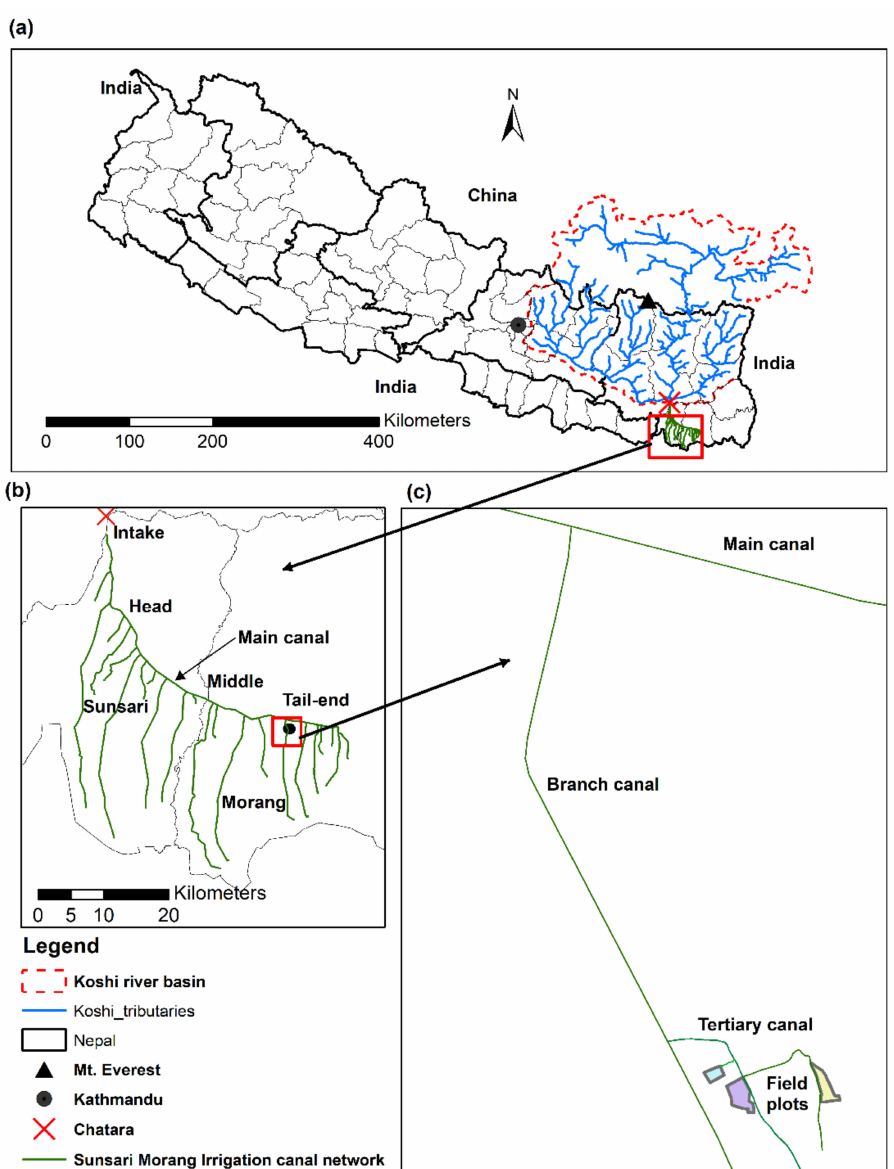
Figure 1. ( a ) The Sunsari Morang Irrigation Scheme. ( b ) Sunsari Morang irrigation canal network. ( c ) The locations of experimental field plots used in this study. Green lines represent the Sunsari Morang irrigation canal network, the blue lines represent tributaries of the Koshi River, and the red dotted line represents the boundary of the Koshi River basin down to the irrigation headwork, marked by a red